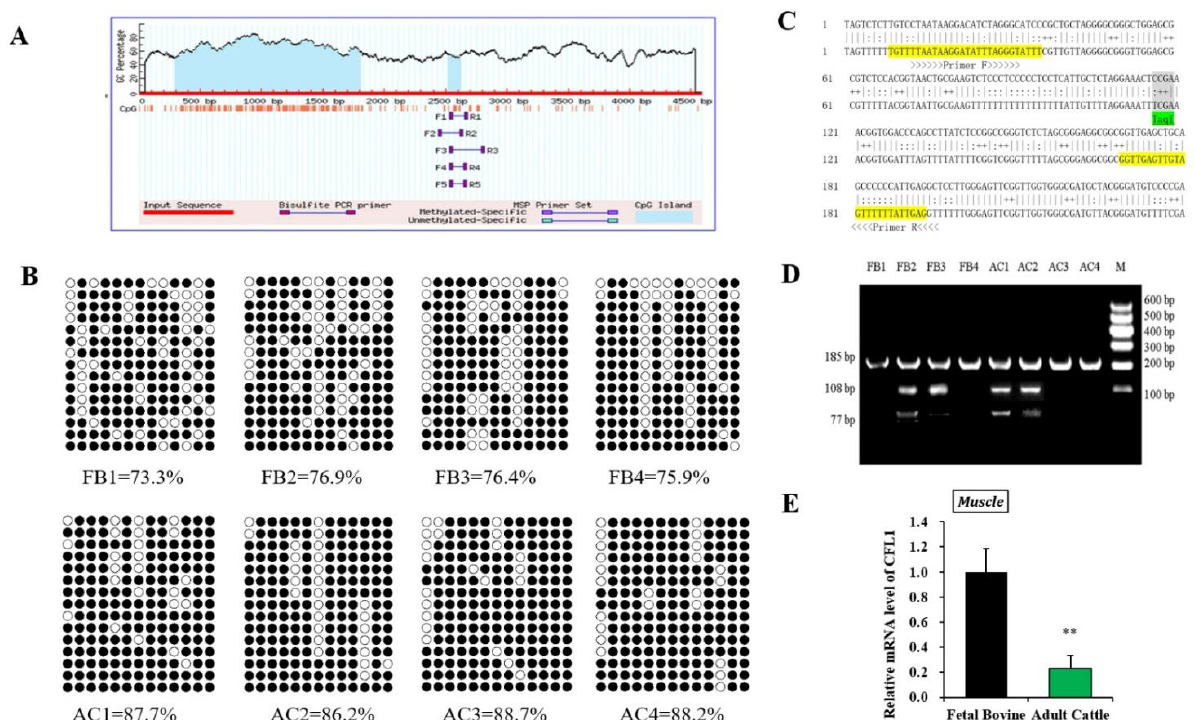
Figure 2. Study on DNA methylation level of CFL1 gene promoter. Schematic representation of the proximal promoter region (+1 to − 4580 base pairs) of the bovine CFL1 gene (modified output of MethPrimer program) to predict regions of high GC content. The 185 bp CpG islands in that promoter are evident in the 5 (cid:48) part of the gene ( A ). DNA methylation patterns of muscle tissue in the fetal bovine group and adult bovine group analyzed by BSP. Each line represents one individ- ual bacterial clone, and each circle one single CpG dinucleotide. Open circles show unmethylated CpG’s and black circles methylated CpG’s ( B ). Nucleotide sequences for a 185 bp CFL1 DMR (to- tal 13 CpG islands) fragment (upper strands) and its bisulfite-converted version (lower strands). Primers sequences are marked with arrows. Squared nucleotides (CpG sites) contain Taq I (“TCGA”) (7th CpG site) restriction sites for COBRA analyses ( C ). DNA methylation patterns of muscle tissues in the fetal bovine group (FB, n = 4) and adult bovine (AB, n = 4) group analyzed by COBRA ( D ). Relative mRNA expression pattern of the CFL1 gene was analyzed in muscle tissues, the mRNA ex- pression level of CFL1 was normalized to GAPDH ( E ). The data represented the mean ± SE based on three independent experiments (**, p < 0.01). M: Marker